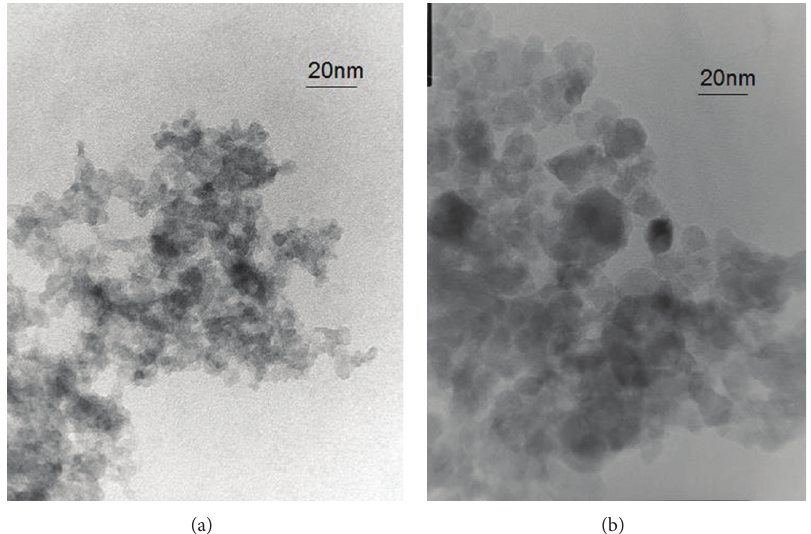
Figure 2: Transmission electron microscopic image of TiO 2 anatase nanoparticles (a, 300x) and TiO 2 15% N doped anatase (b, 300x). Table 1: Effect of different TiO NPs on growth and kinetic parameters of different microorganisms. 2 C. vulgaris H. pluvialis A. Sample